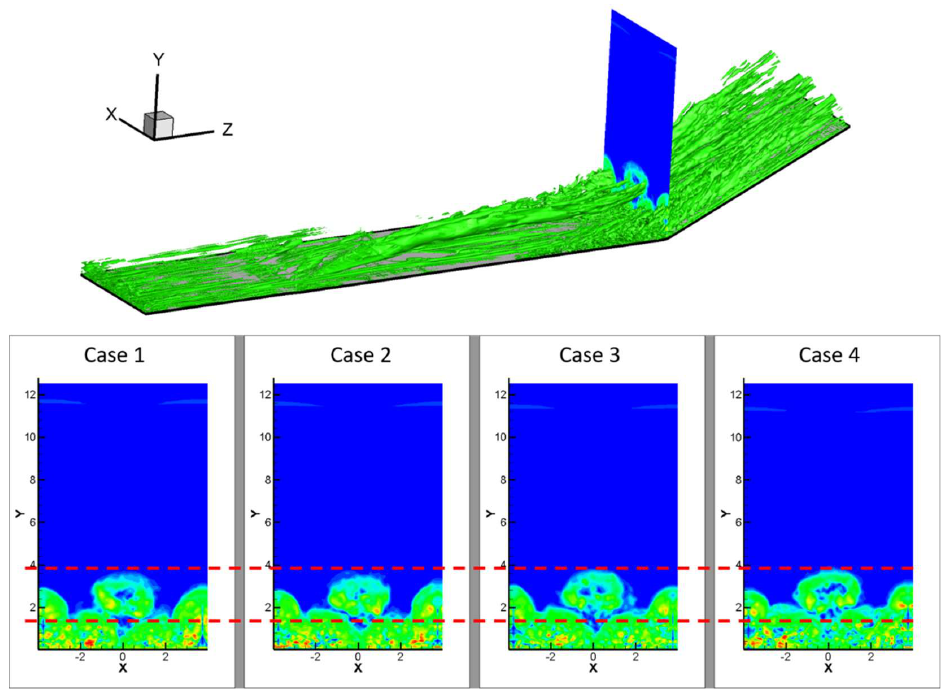
Figure 8. The position of ring-like vortex at the ramp corner.